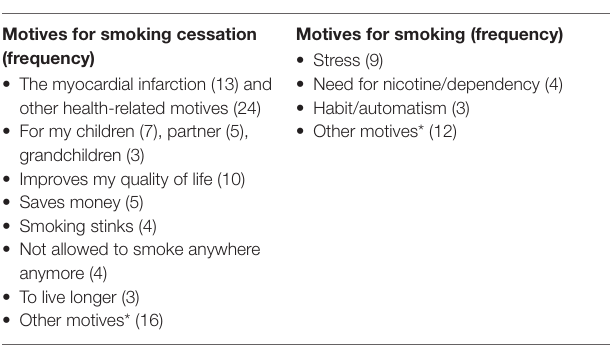
TABLE 6 | Motives for (not) smoking. Motives for smoking cessation